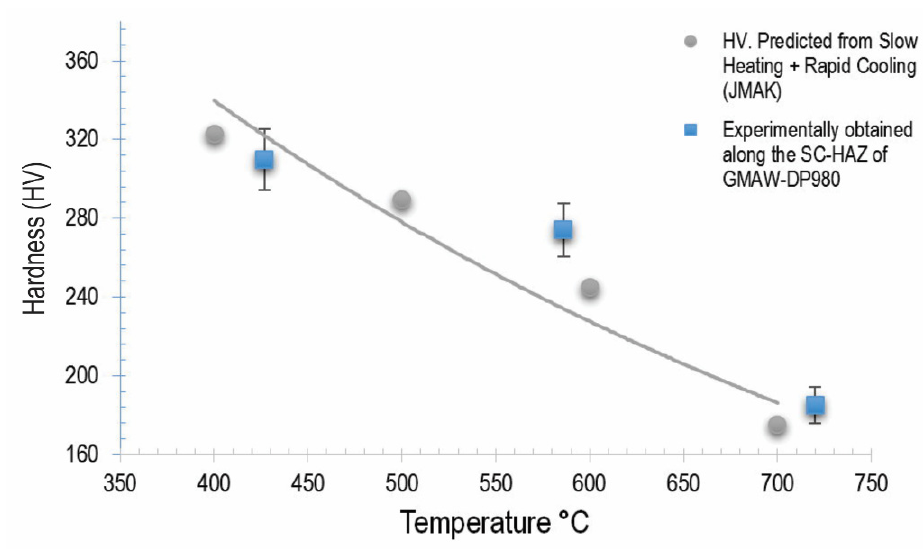
Figure 11. Comparison between the predicted hardness and the measured hardness at specific locations along SC-HAZ of GMAW DP980 steel.